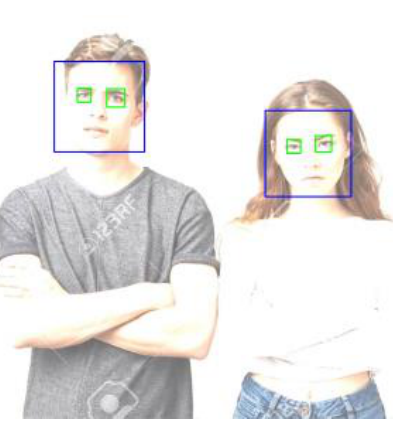
Figure 34. After increasing the brightness of Figure 32.